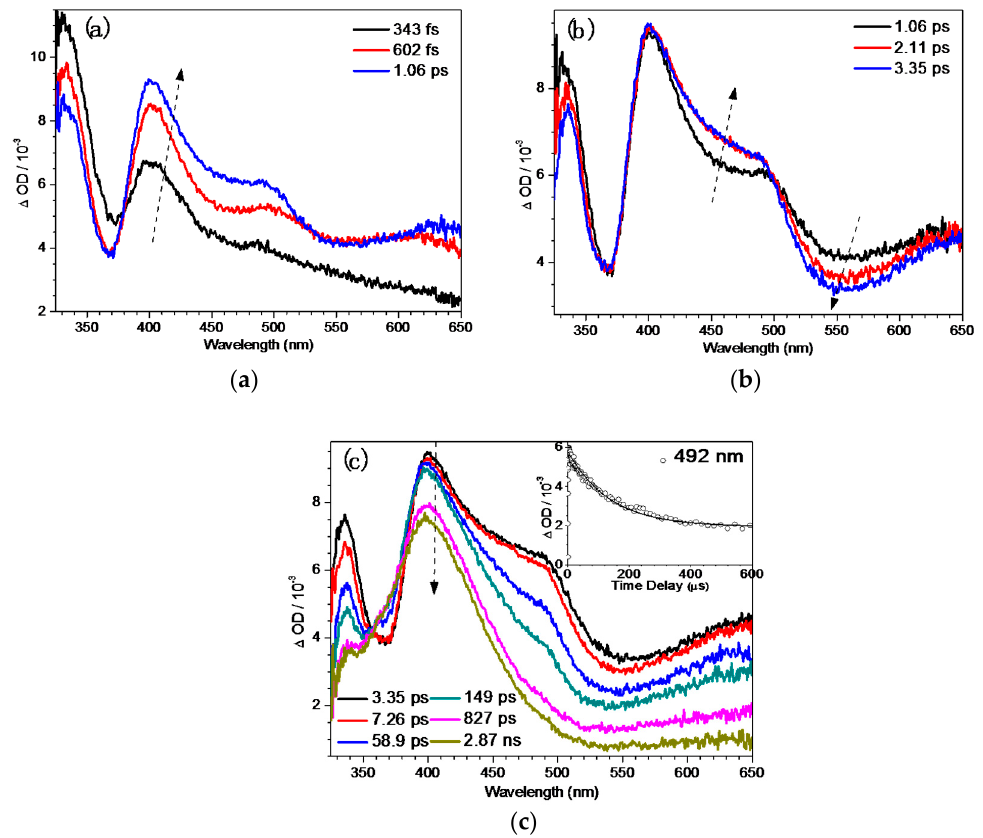
Figure 5. The fs-TA spectra of BQMP-b obtained after 266 nm excitation in MeCN:H 2 O (1:1, pH = 12) ( a ) from 343 fs to 1.06 ps, ( b ) from 1.06 ps to 3.35 ps, ( c ) from 3.35 ps to 2.87 ns; inset: kinetics at 492 nm.